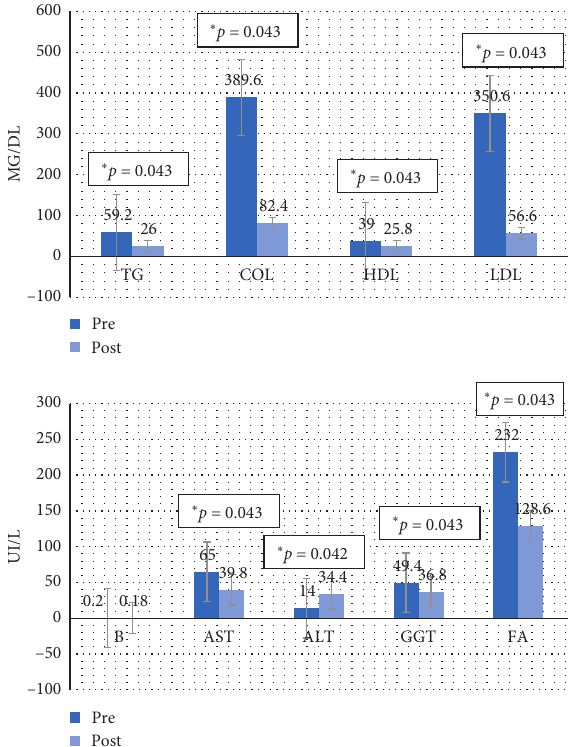
Figure 7: Average values of the pre-post parameters for group 4. TG � triglycerides, COL � total cholesterol, HDL � HDL choles- terol, LDL � LDL cholesterol, B � bilirubin, AST � aspartate ami- notransferase, ALT � alanine aminotransferase, GGT � gamma- glutamyl transferase, FA � alkaline